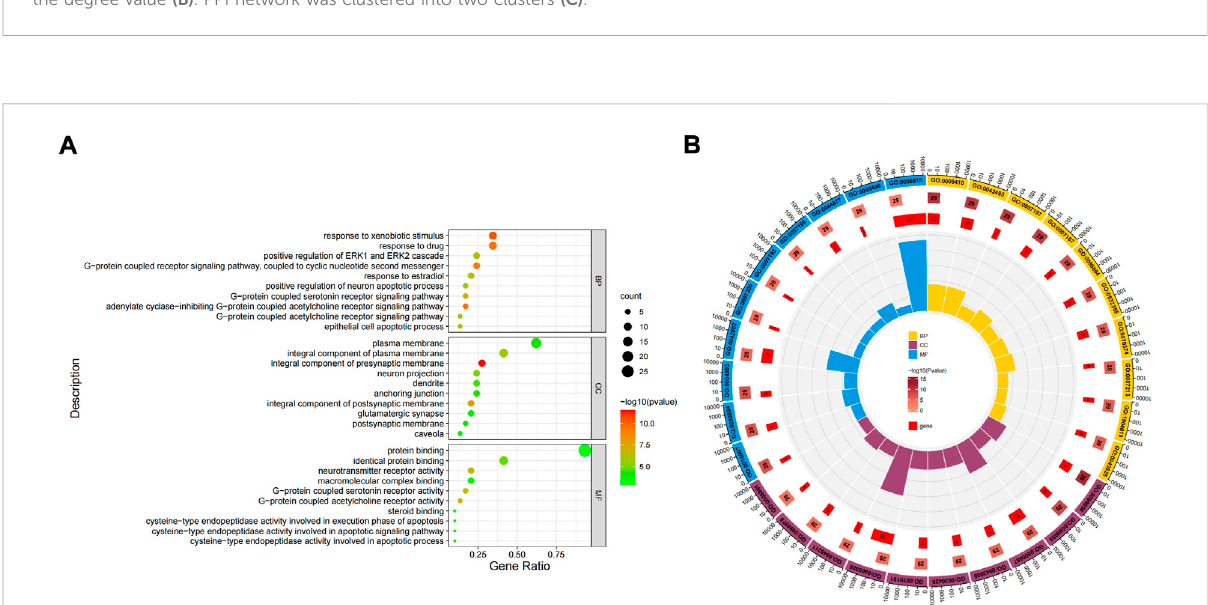
FIGURE 5 GeneOntology(GO)functionenrichmentanalysisofFIBinthetreatmentofIschemicStrokes.EnrichmentdiagramofBP,CC,andMFterms (A) . The cluster analysis of high correlation GO terms (B)